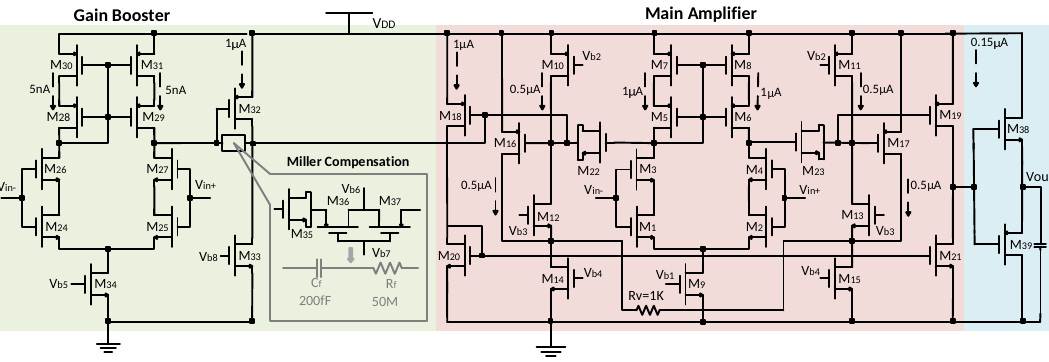
Figure 5. Schematic of the proposed gain-boosted two-stage operational amplifier with load-insensitive stability compensation. Table 2. Transistors size of the proposed